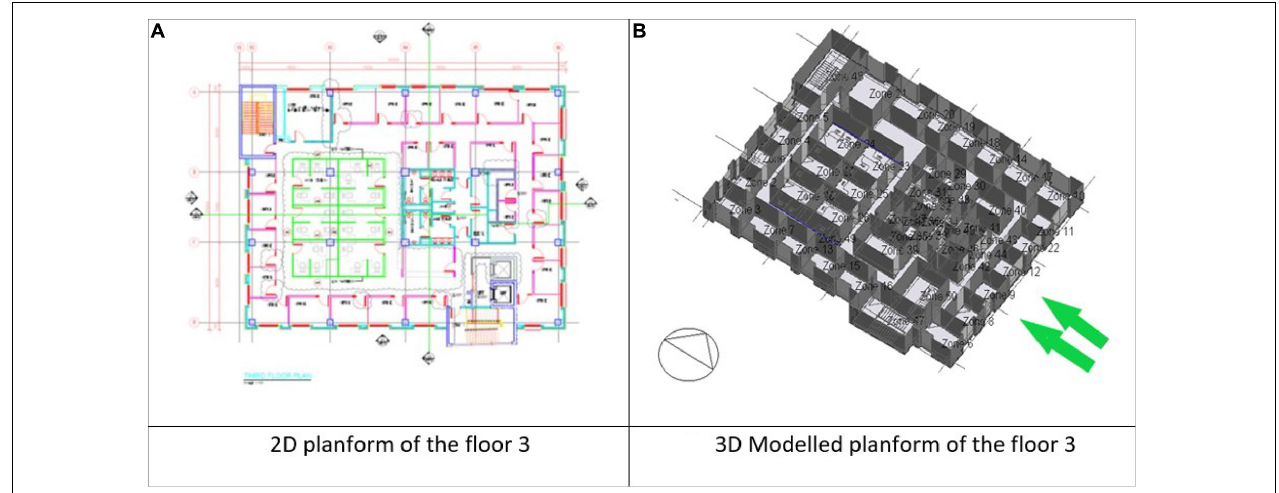
FIGURE 13 | 2D and 3D planforms of the floor 3 in the ACK building. (A) 2D planform. (B) 3D modelled planform.